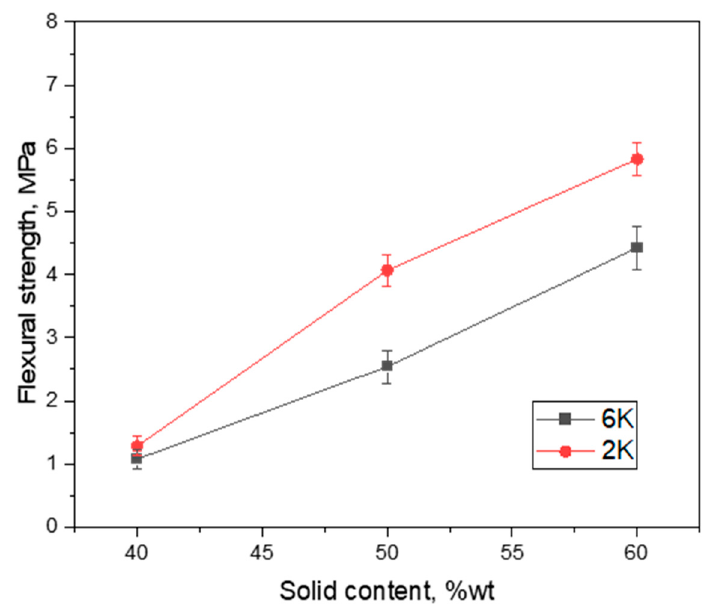
Figure 7. Influence of solid content and freezing rate on flexural strength of freeze cast cement samples.